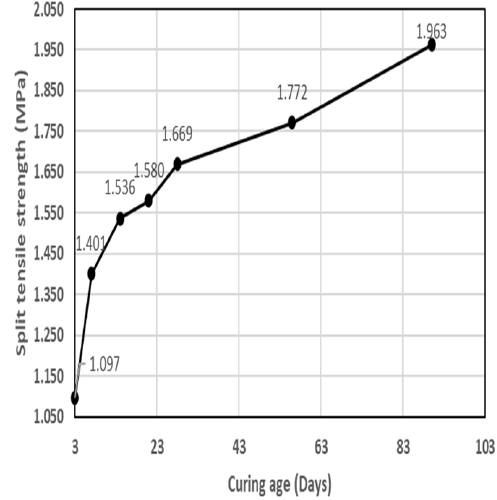
Figure 19. Variation of split tensile strength.